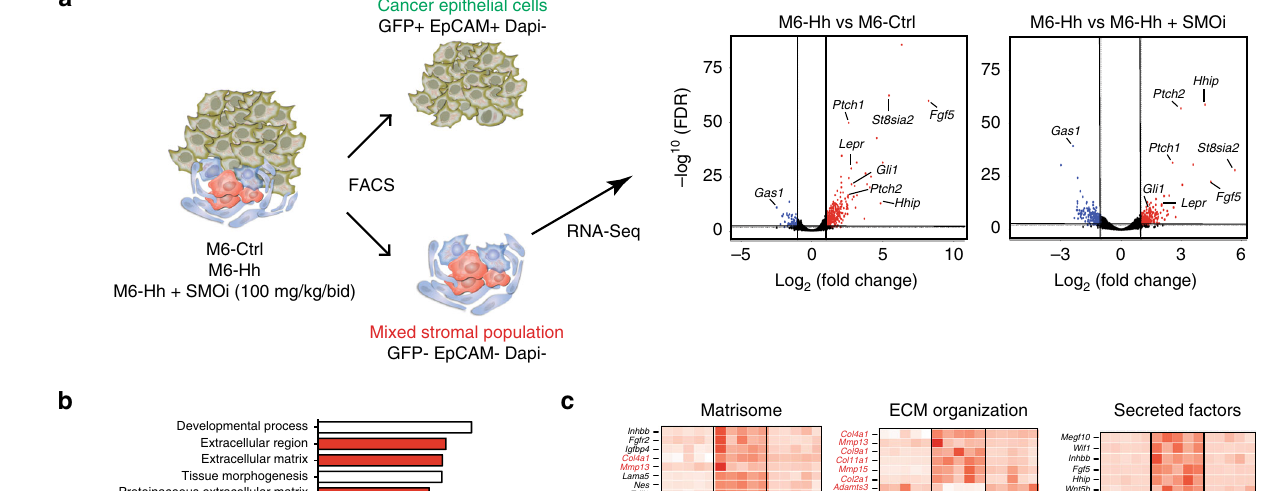
value)0 105 15 20 –log 10 ( P